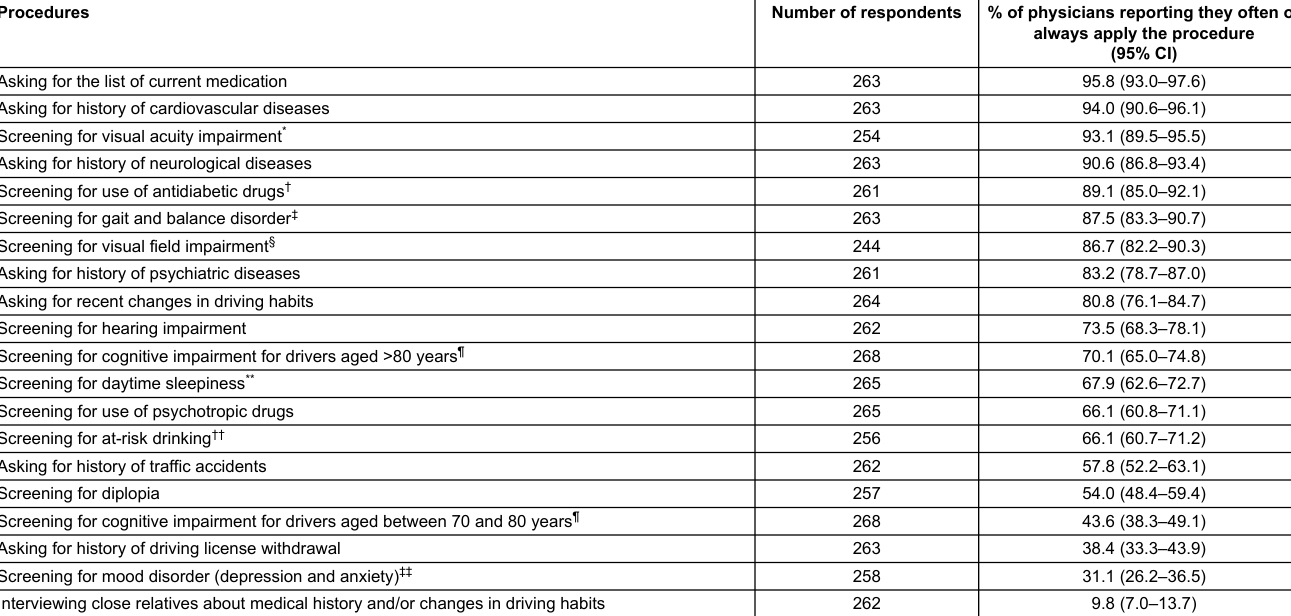
Table 3: Twenty procedures emphasised during assessment of older